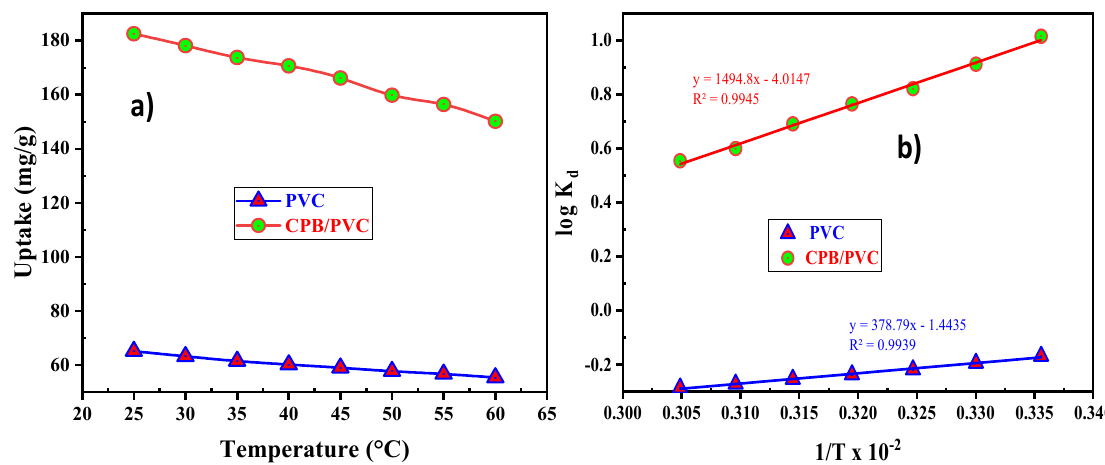
Figure 9. ( a ) Effect of temperature on REE uptake, and ( b ) log K d vs. 1/T relation of REE sorption on PVC, and CBP/ PVC.